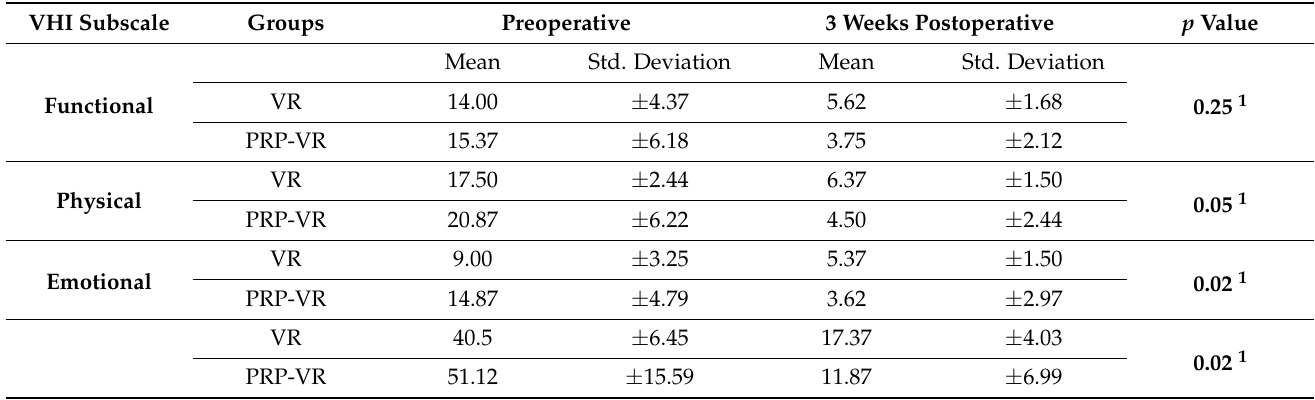
Table 4. Subjective voice assessment between groups using the VHI-30